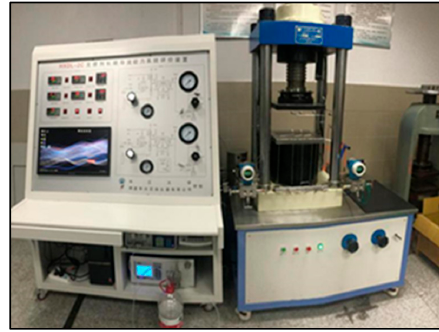
Figure 11. HXDL-2 system for conductivity.